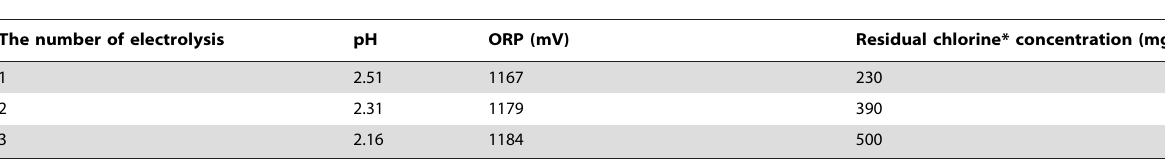
Table 2. Characteristic values of AEW obtained from 1% NaCl solution.